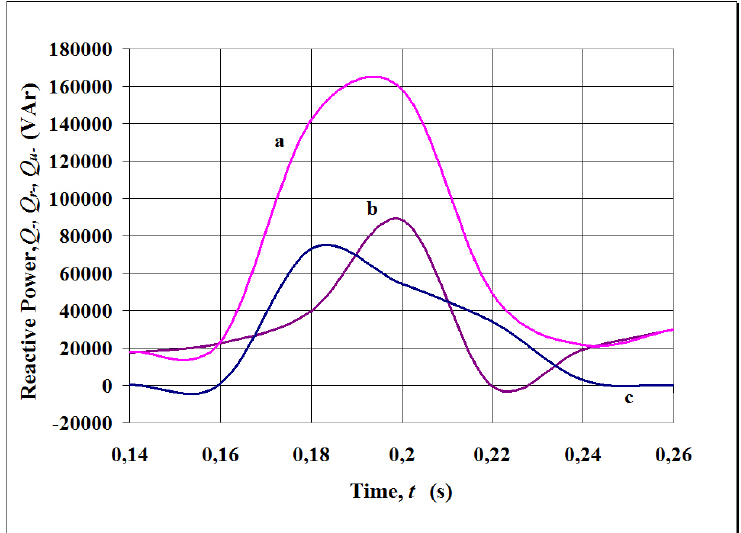
Figure 10. Negative-sequence reactive powers: ( a ) total, ( b ) due to reactive loads, ( c ) caused by